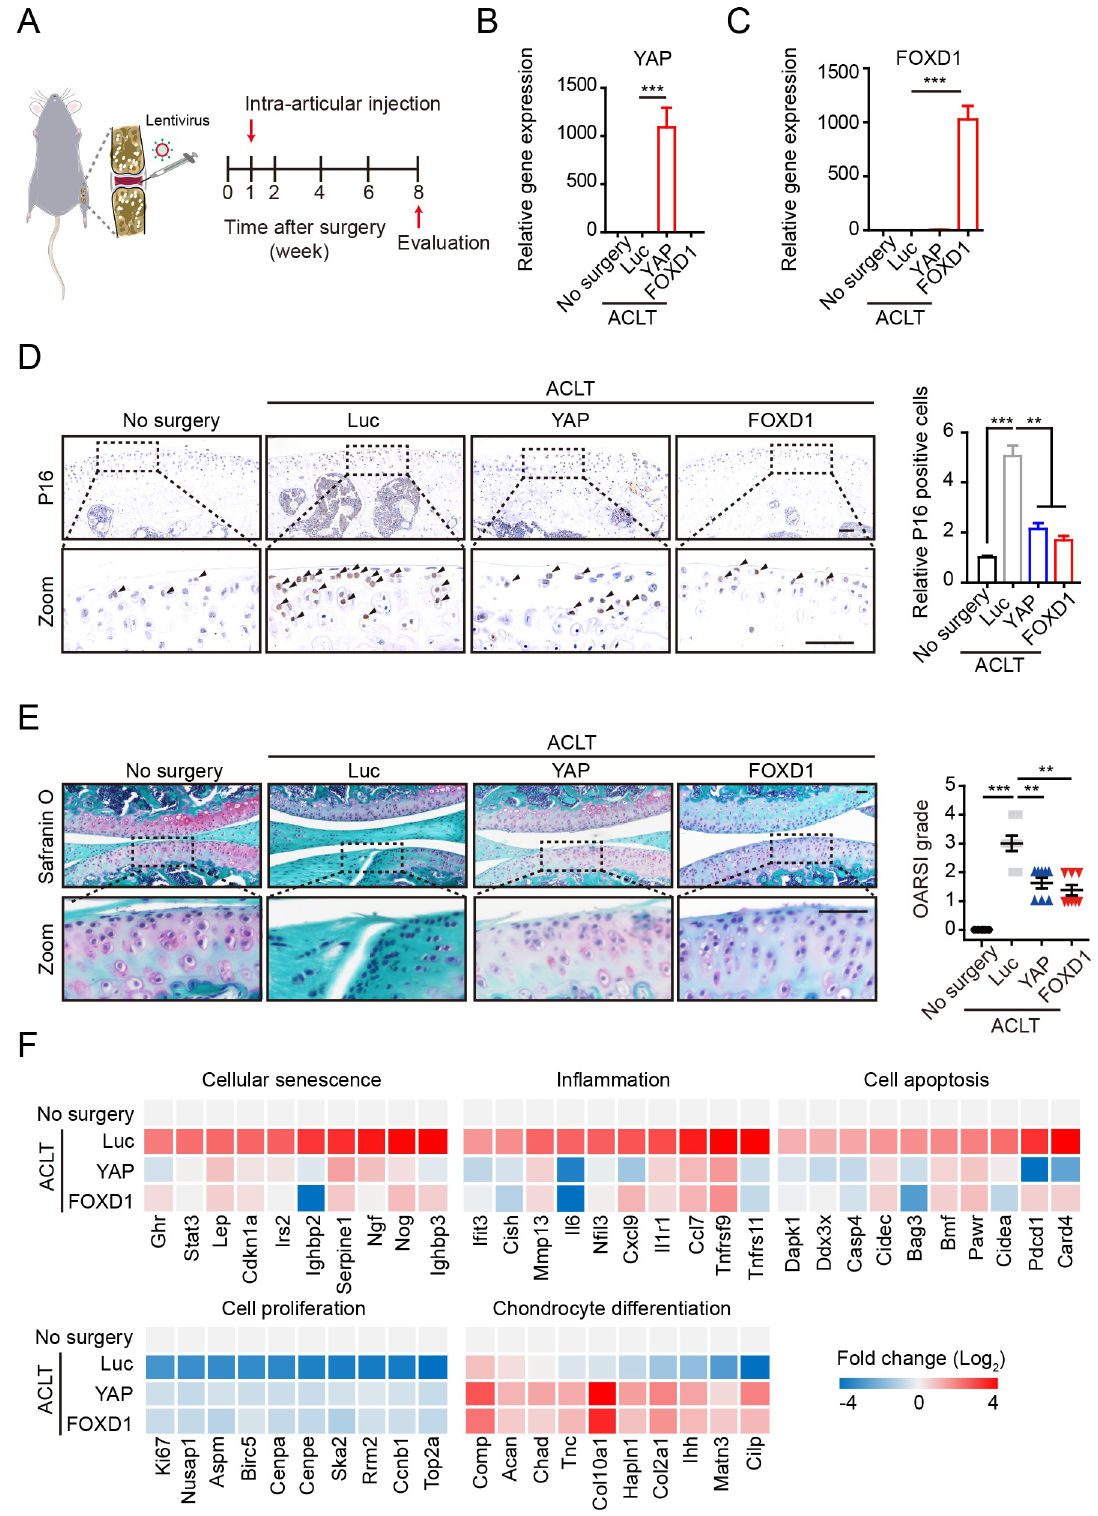
Fig 6. The YAP and FOXD1 gene therapy alleviates osteoarthritis in mice. (A) Schematic of the time course used for the in vivo osteoarthritis experiments. (B and C) RT-qPCR analysis of YAP and FOXD1 expression in the joints of mice that did not